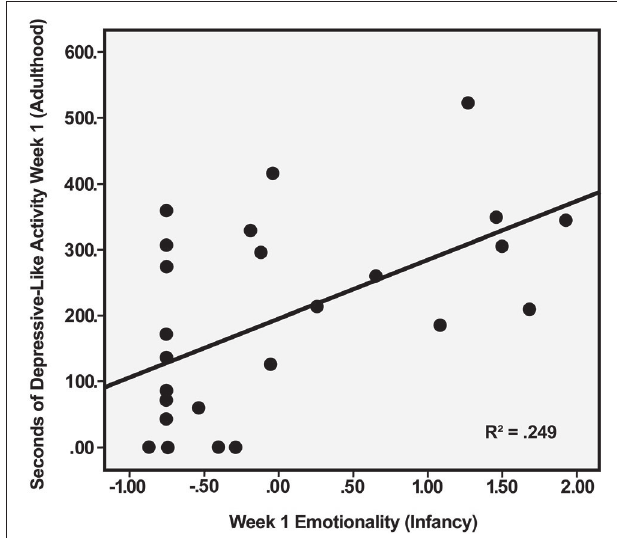
FIGURE 1 | Relation between Emotionality factor score of male rhesus monkeys during first day of social separation in infancy and duration of depressive-like behavior (maximum possible = 600 s) during first week of individual housing in adulthood, p < 0.02